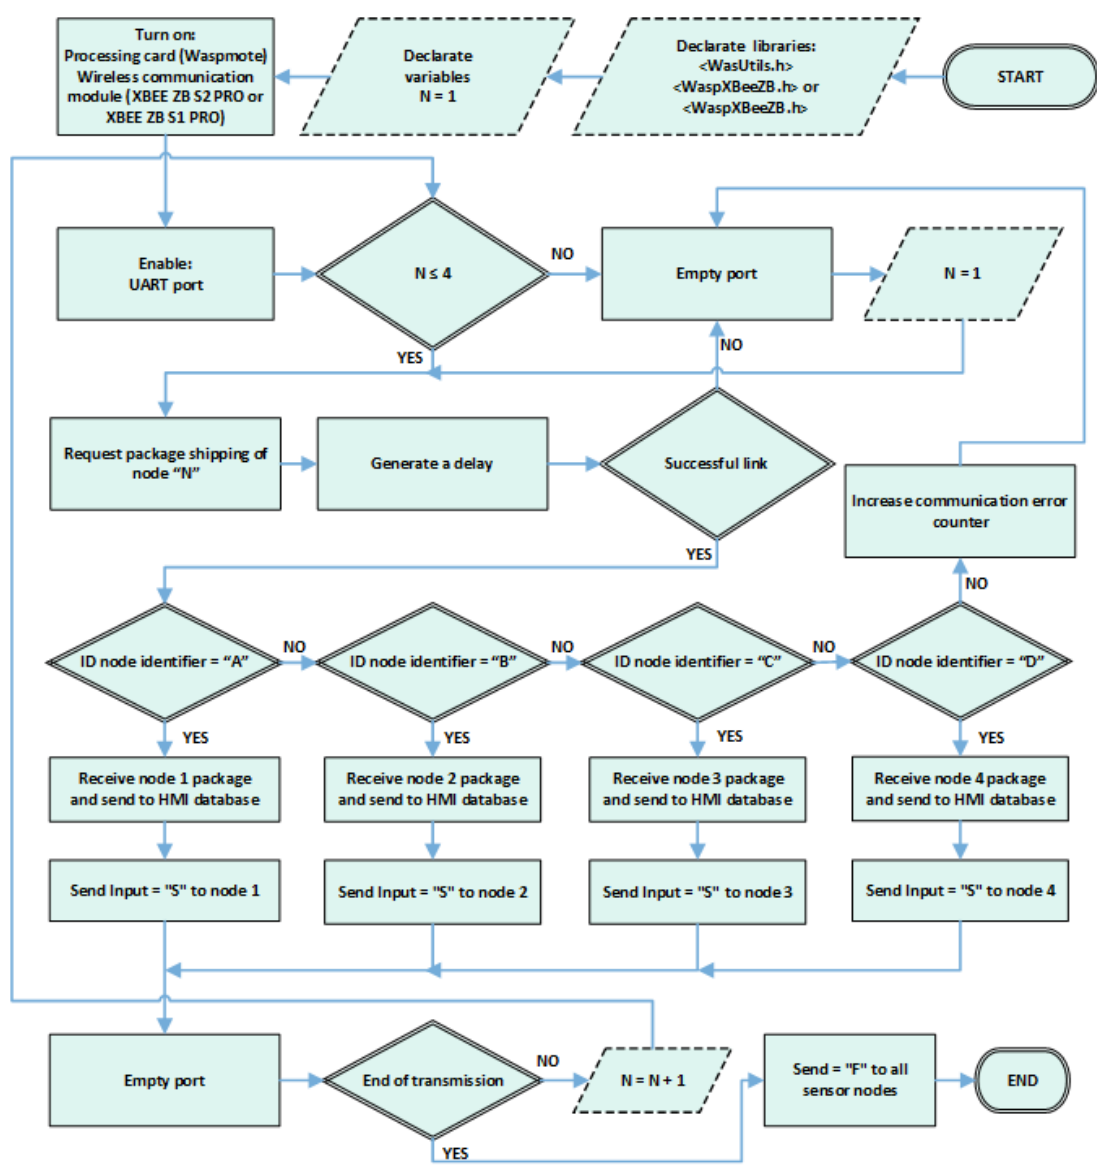
Figure A3. Flowchart of logic programming coordinator nodes of the of ZigBee and DigiMesh